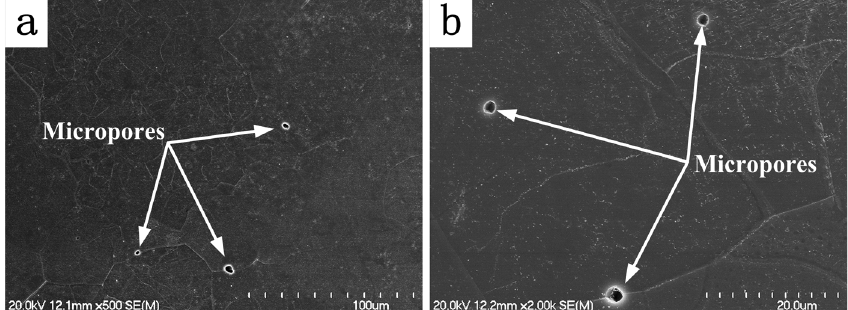
Figure 5. SEM images of the residual micropores in as-consolidated PM Ti-5553